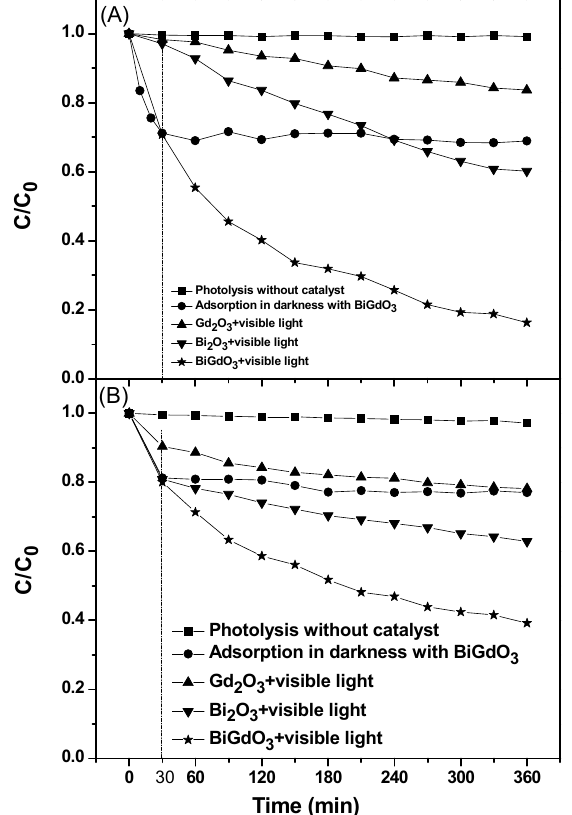
Figure 8. Comparison of removal efficiencies between Direct Orange 26 ( A ) and Direct Red 23 ( B ) under different conditions.